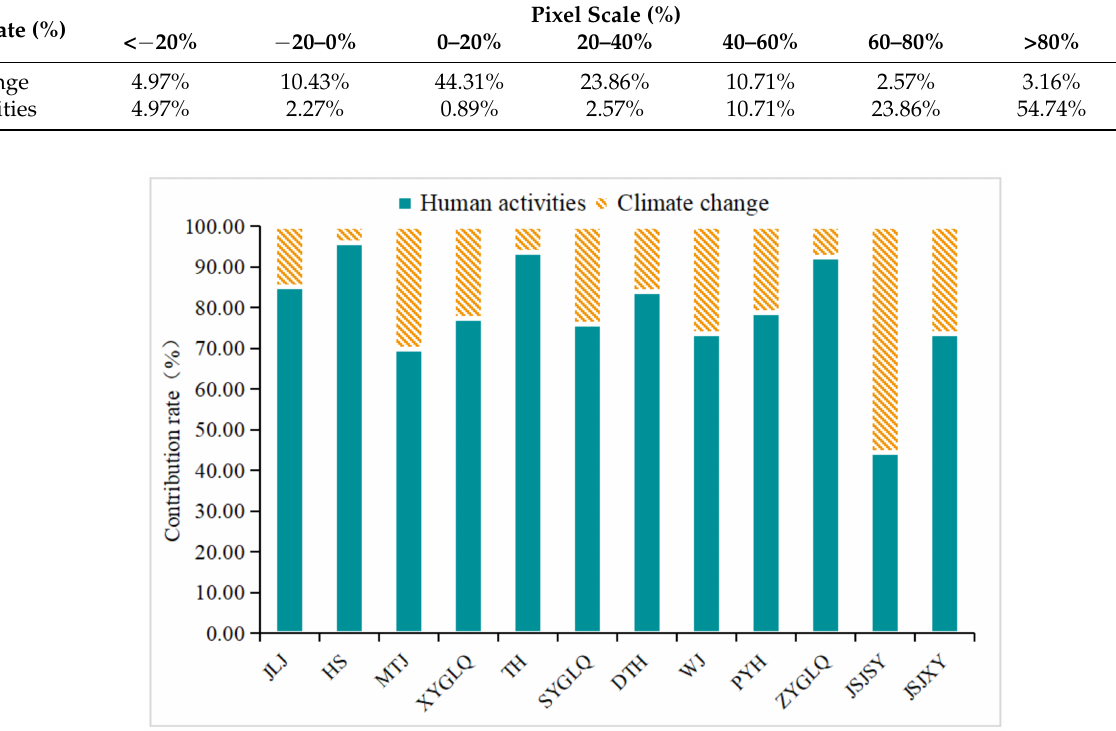
Figure 11. Contribution of climate change and human activities to vegetation cover change in sub- basin from 2000 to 2019. JLJ: Jialing River Basin; HS: Han River Basin; MTJ: Min and Tuo River Basin; XYGLQ: lower main stream area; TH: Taihu Lake Basin; SYGLQ: upper main stream area; DTH: Dongting Lake Basin; WJ: Wu River Basin; PYH: Poyang Lake Basin; ZYGLQ: middle reaches of the main stream; JSJSY: upstream of Jinsha River Basin; JSJXY: downstream of Jinsha River